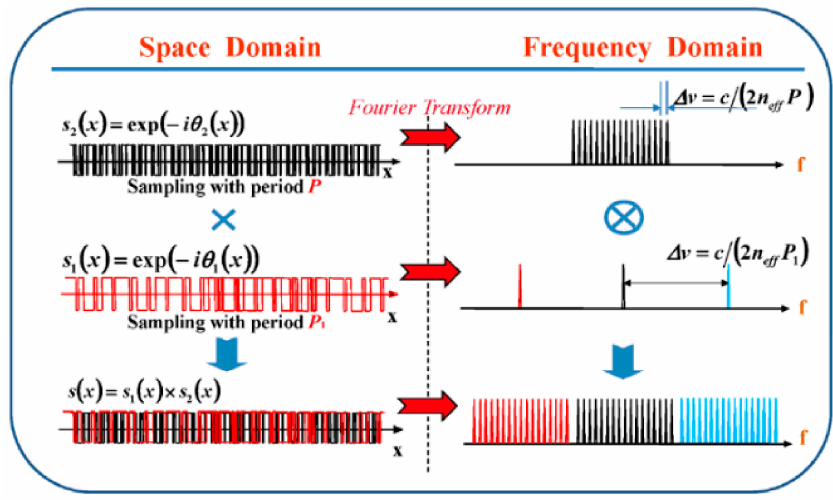
Figure 18. Principle of the double phase-only sampling method based on the Fourier analysis. Adapted with permission from ref. [116]. © The Optical Society.